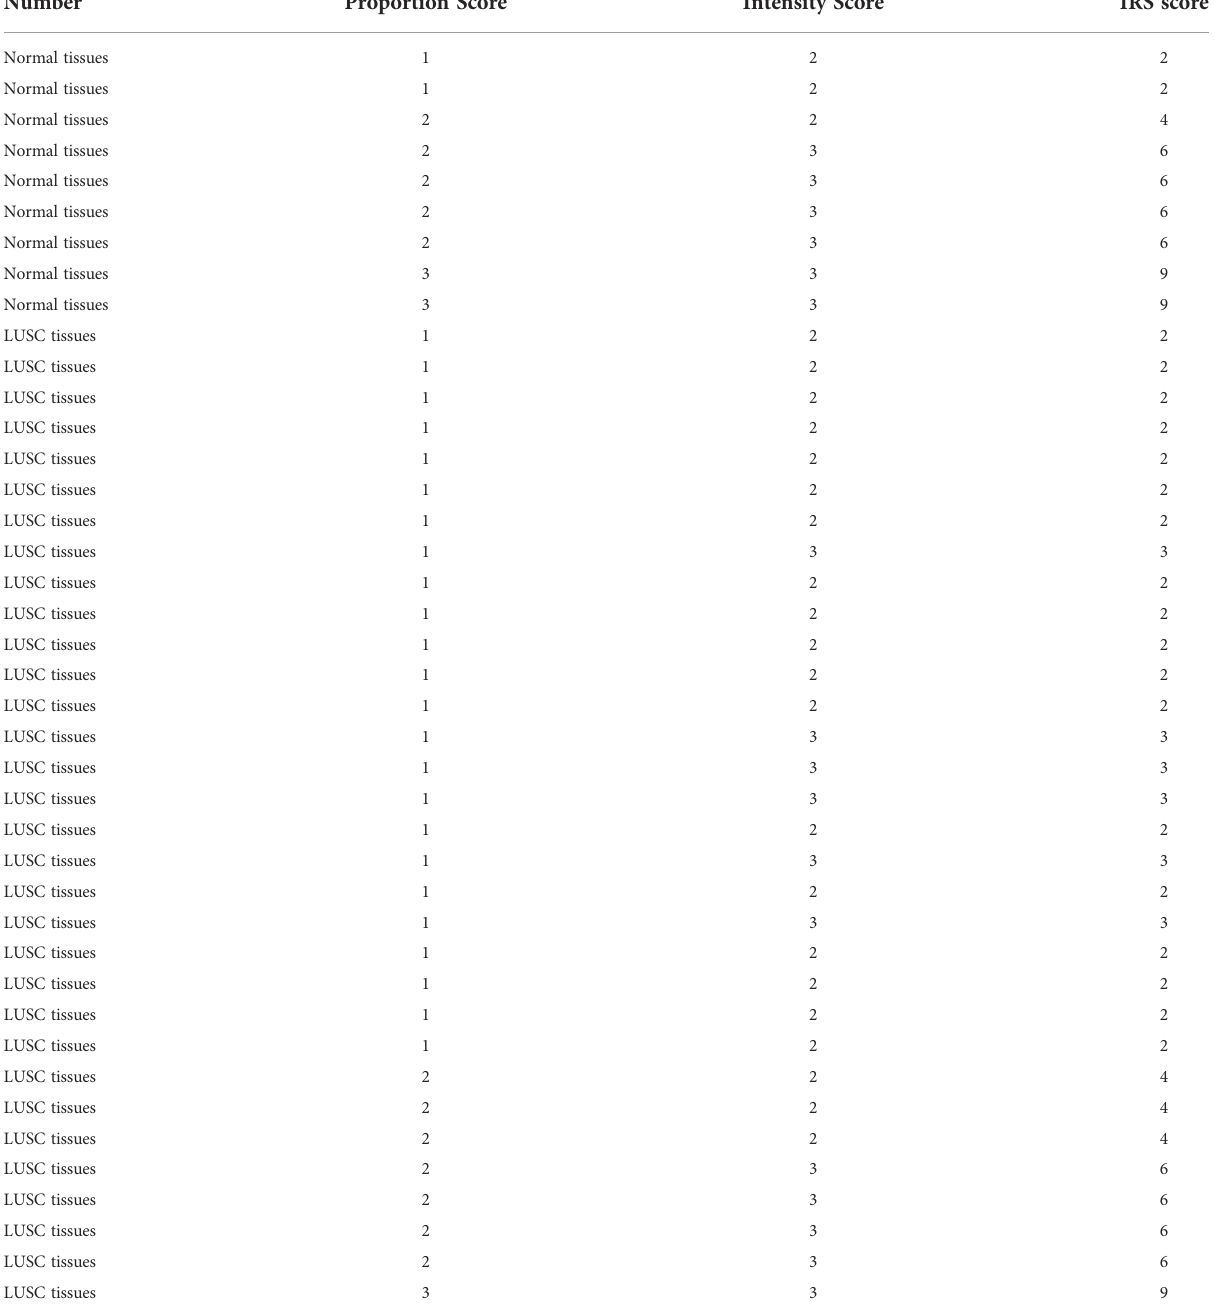
TABLE 1 The IL18R1 expression levels in the tissues of patients with LUSC. Number Proportion